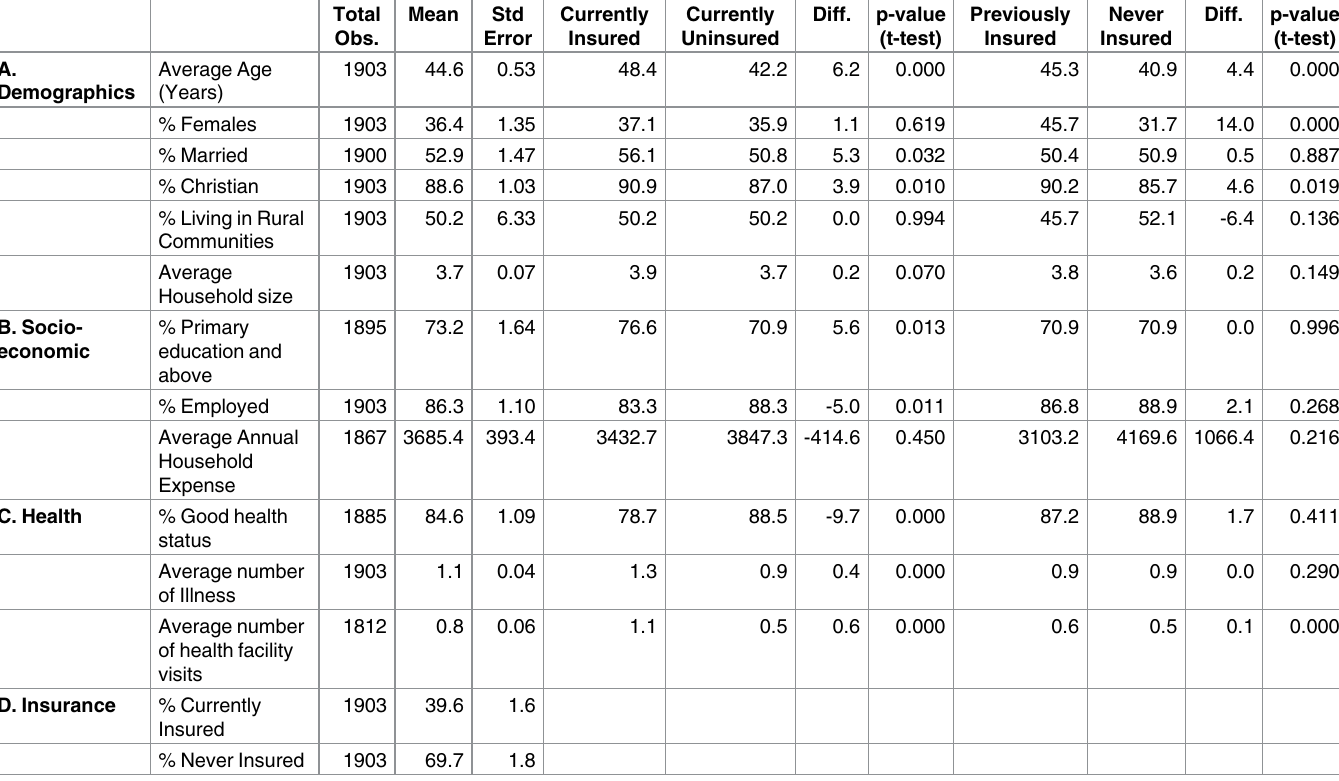
Table 1. Descriptivecharacteristics and health insurance enrolment of respondents. Total